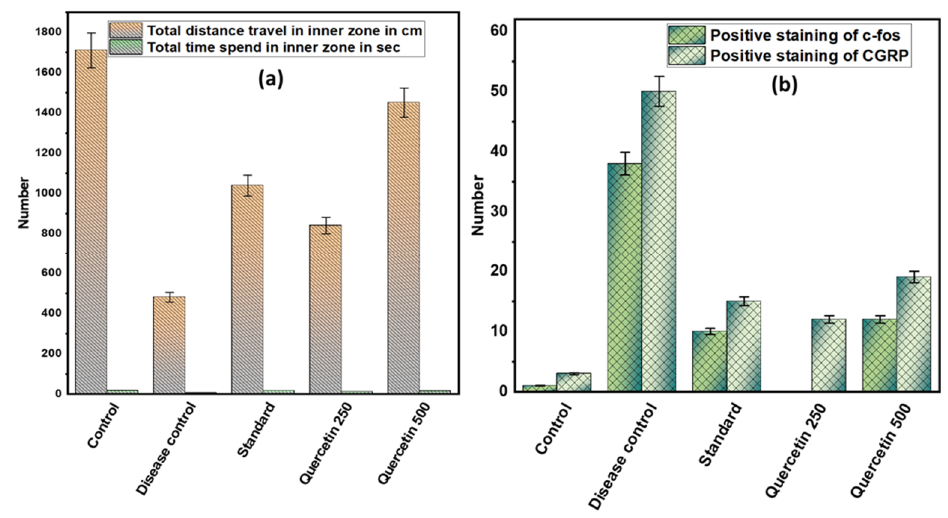
Figure 5. ( a ) Effect of quercetin on NTG-induced depression or anxiety in rats; ( b ) effect of quercetin on c-fos and CGRP immunoreactive cells in the TNC in rats. on c-fos and CGRP immunoreactive cells in the TNC in